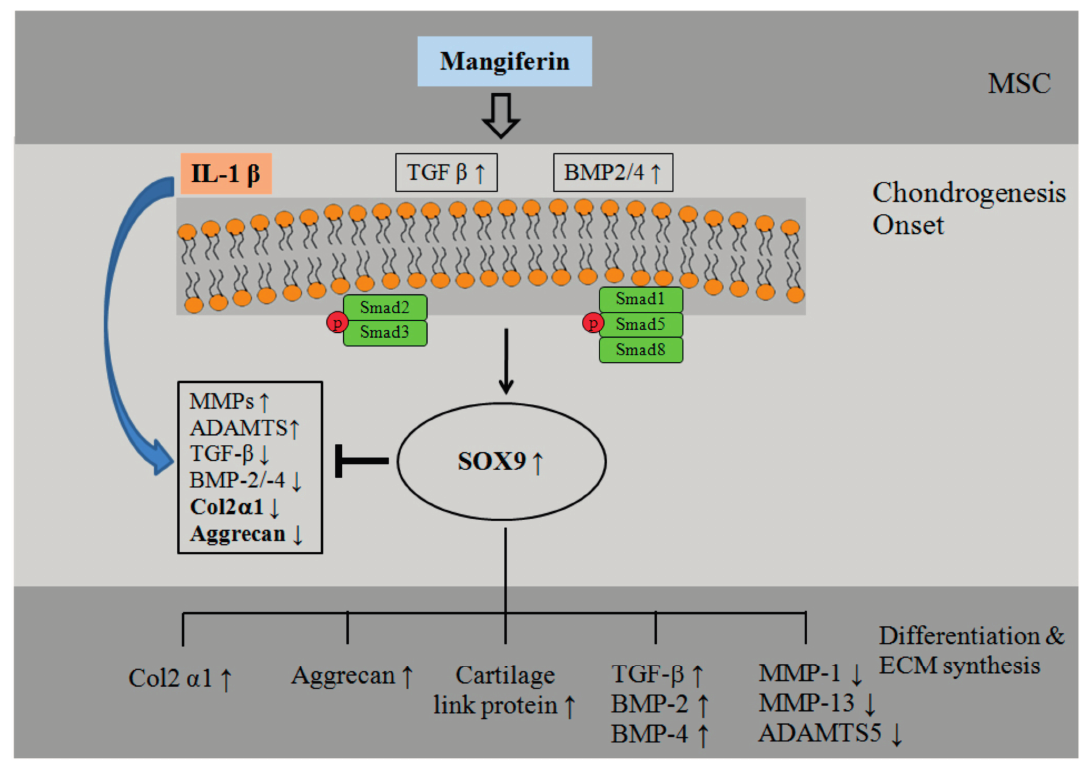
Figure 6. Schematic model of the pathways by which mangiferin stimulates SOX-9, a key transcription factor of TGF- β /BMPs-induced chondrogenesis, and activates the phosphorylation of Smad 1/5/8 and Smad 2/3 signaling pathways. → activation; ┤ inhibition; ↑ increase; ↓